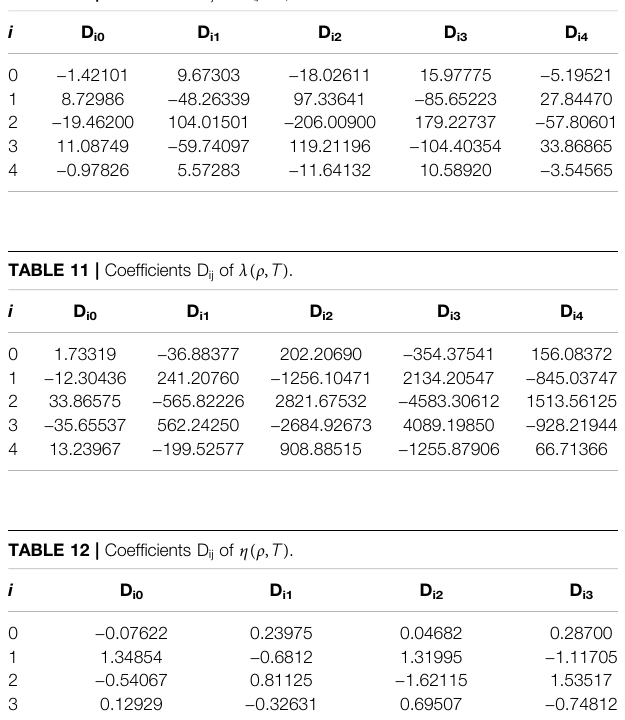
TABLE 10 | Coef fi cients D ij of h ( p , T ) .